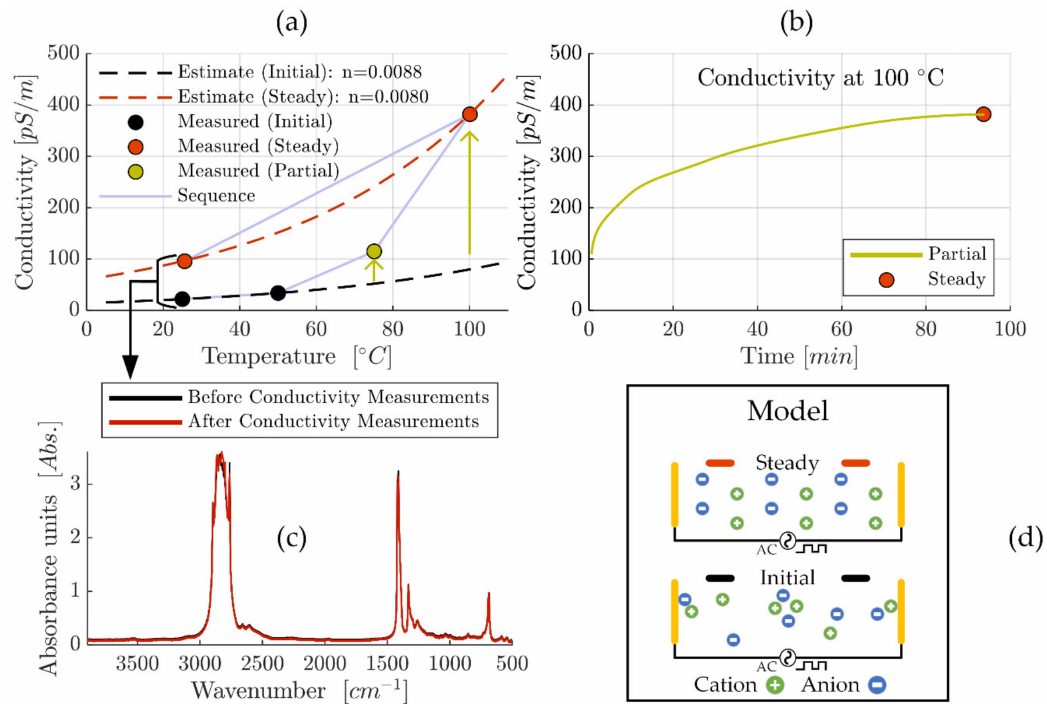
Figure 3. Conductivity analysis of ‘MAC &P-SiSO’, containing 0.4 wt% P-SiSO in MAC. ( a ) Conductivity measured sequentially from 25 ◦ C to 100 ◦ C in increments of 25 ◦ C, before cooling down to 25 ◦ C. Dashed lines represent ASTM D2624 temperature-conductivity relations estimated for initial and steady state. ( b ) Detailed view of initial 100 min of conductivity measurement at 100 ◦ C shows time-dependency of conductivity. ( c ) Fourier transform infrared spectroscopy (FTIR) analysis before first and after last conductivity measurements confirm chemical stability. ( d ) Schematic illustration to explain the observed time-dependency of